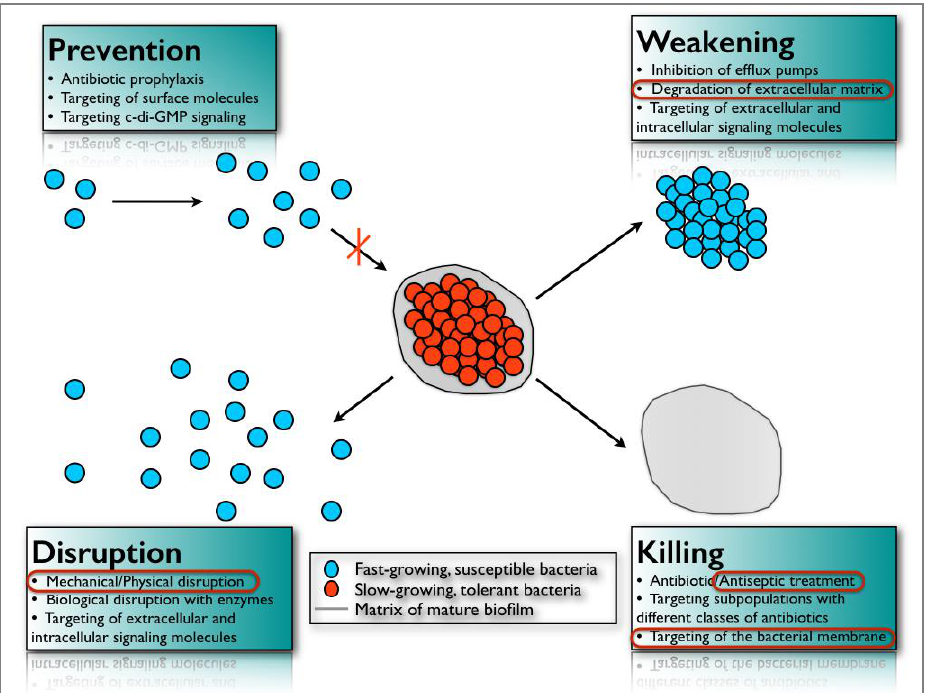
Figure 6. The four anti-biofilm strategies. (Adapted from [102]).